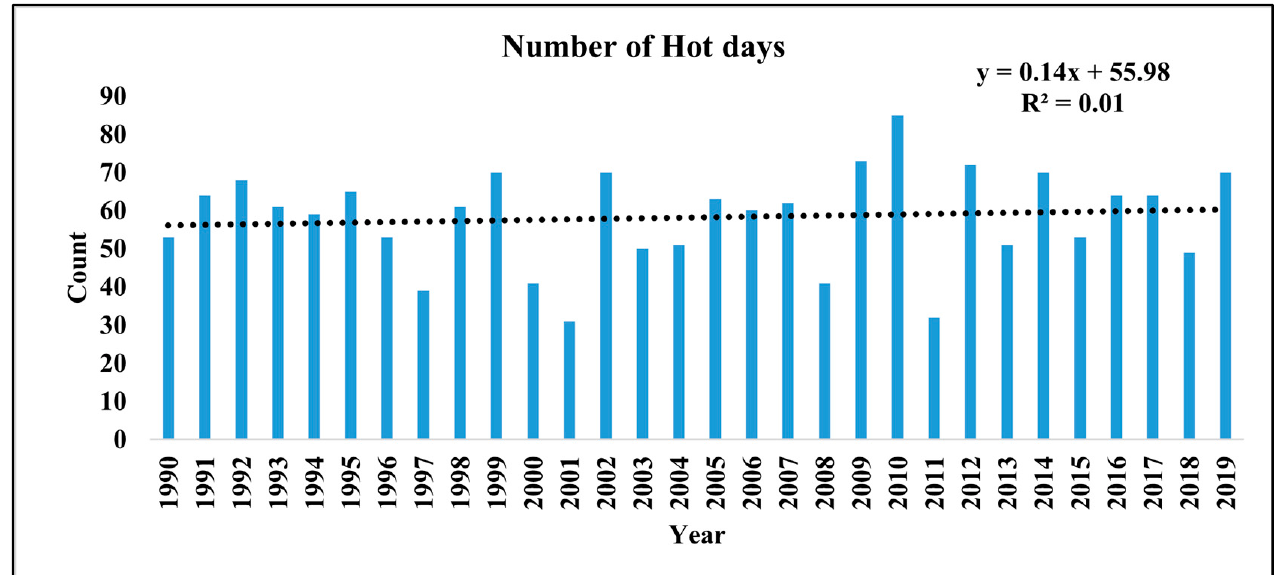
Figure 8. The time series of the number of hot days.